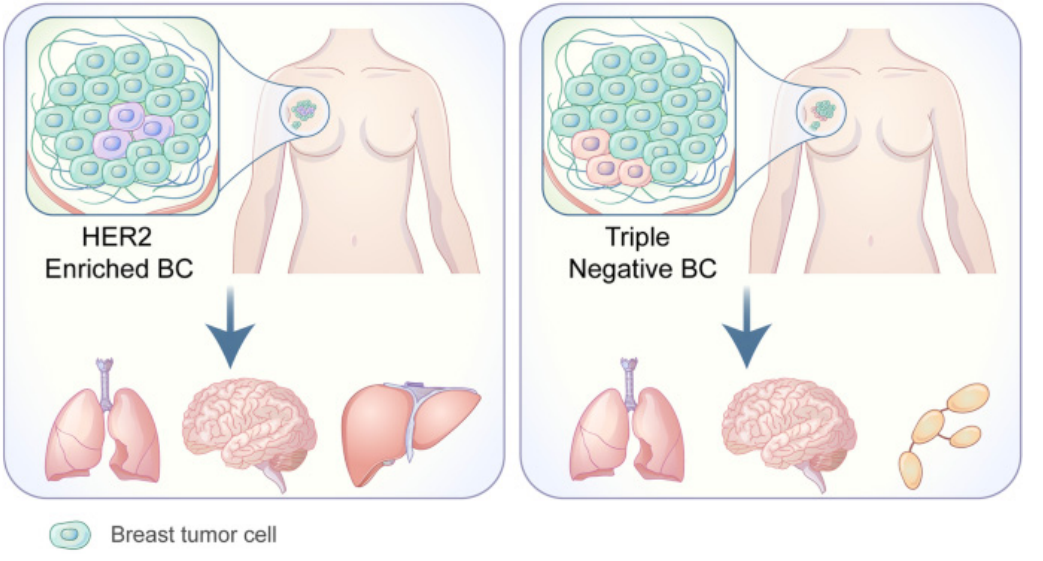
Figure 4. Adapted from Wang C, Xu K, Wang R. Heterogeneity of BCSCs contributes to the metastatic organotropism of breast cancer. J. Exp. Clin. Cancer Res. 2021, 40, 370 (2021). http://doi.org/10.1186/s13046-021-02164-6 [25,75]. http://creativecommons.org/licenses/by/4.0/, accessed 2 May